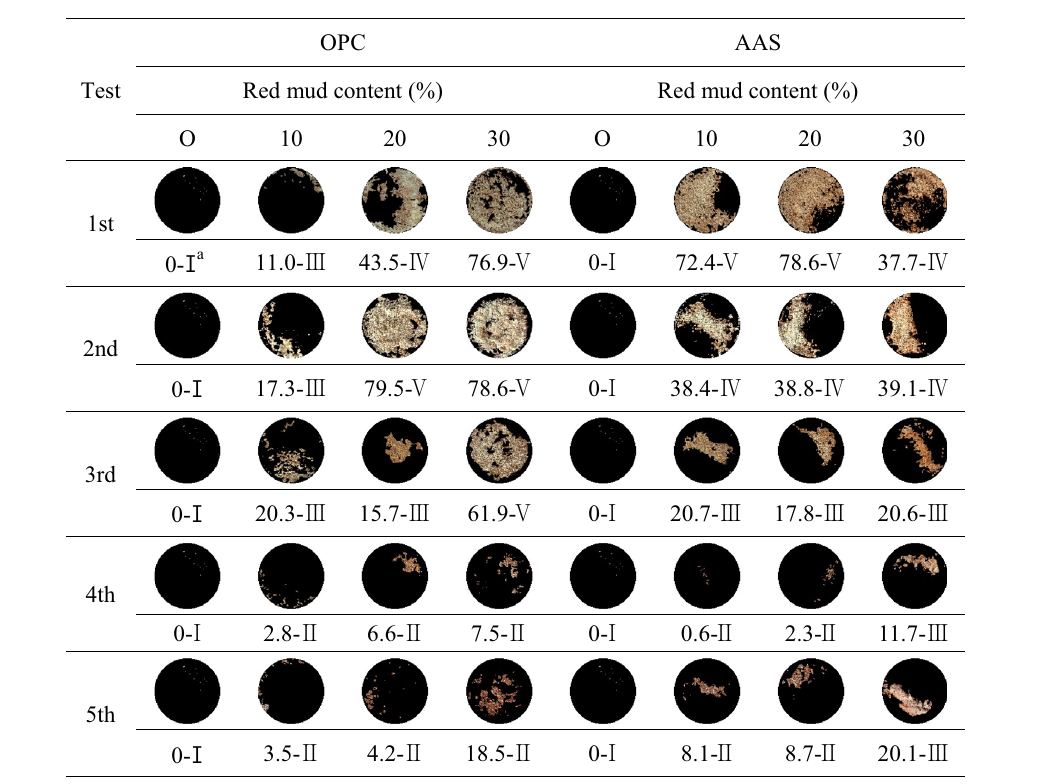
Table 6 Efflorescence characteristics.